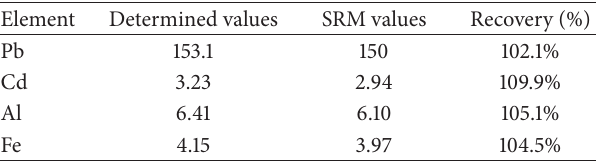
Table 3: Validation of extraction and analysis of standard references